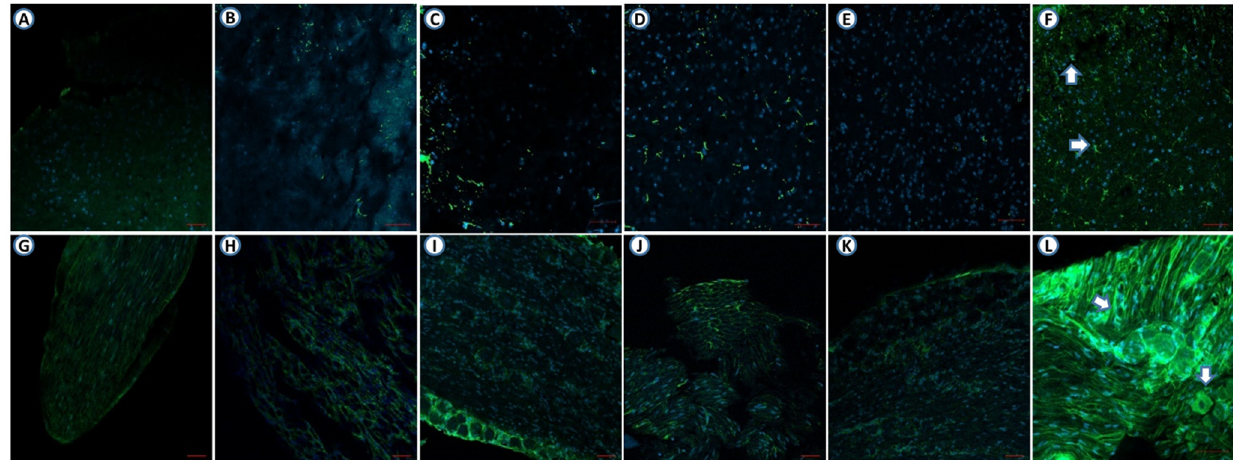
Figure 3. The effect of intraperitoneal injection of mixed drugs on the expression of GFAP (luminous green) in the spinal cord and dorsal root ganglion of the CPIP model. Original magnification; ×200. ( A ) GFAP immunohistochemical staining of the spinal cord of mice in sham operation group (n = 4). ( B ) Pre20 mg/kg + Tra10 mg/kg-injected CPIP mouse ( n = 6). ( C ) Pre15 mg/kg + Dul15 mg/kg-injected CPIP mouse ( n = 6). ( D ) Dul30 mg/kg + Tra10 mg/kg-injected CPIP mouse ( n = 6). ( E ) Pre10 mg/kg + Dul10 mg/kg + Tra10 mg/kg-injected CPIP mouse ( n = 6). ( F ) normal saline-injected CPIP